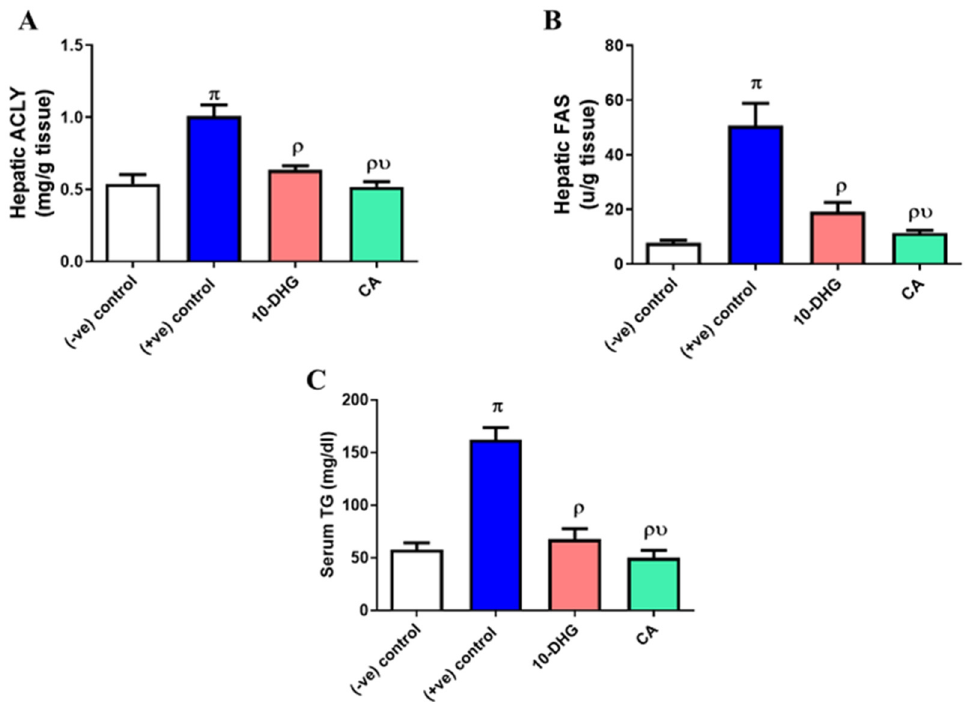
Figure 3. Effect of caffeic acid and 10-dehydrogengerdione treatment on hepatic ( A ) ACLY; ( B ) FAS and ( C ) serum triglyceride. (-ve) control: rats received standard rodent diet; (+ve) control: diabetic rats received CCT diet without receiving any treatment; 10-DHG: diabetic rats received CCT diet and 10-dehydrogengerdione (10 mg/kg/day); CA: diabetic rats received CCT diet and caffeic